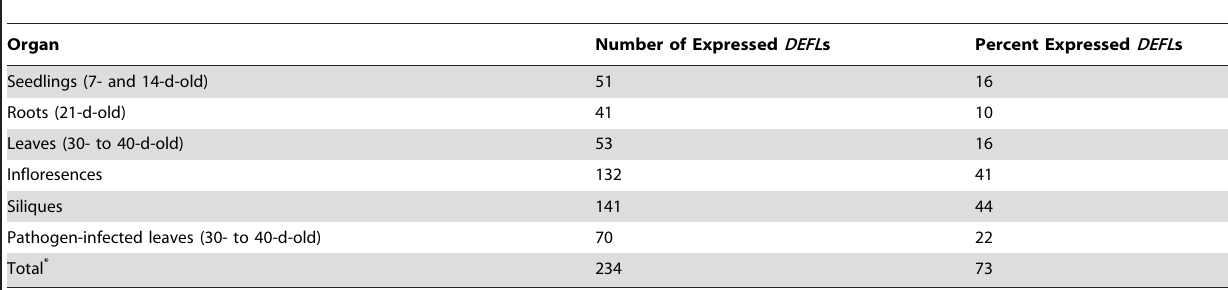
Table 1 . Number of Arabidopsis DEFL expression by tissue and condition